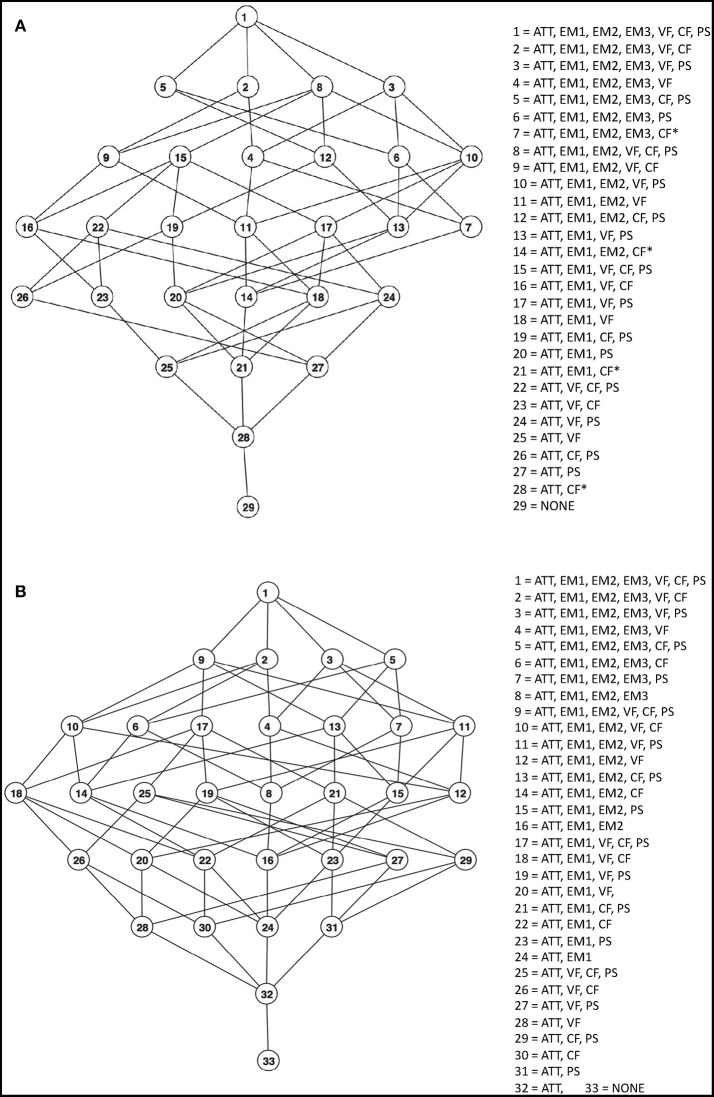
(A) ADNI2 POSET model for cognitive functioning. Attributes of each level are listed in more detail in Table 4A. (B) AIBL POSET model for cognitive functioning. Attributes of each level are listed in more detail in Table 4B. The cognitive functions listed represent high proficiency in those functions. ATT, attention; EM1, EM2, EM3, episodic memory level 1, 2, or 3; VF, verbal fluency; CF, cognitive flexibility; PS, perceptual motor speed.